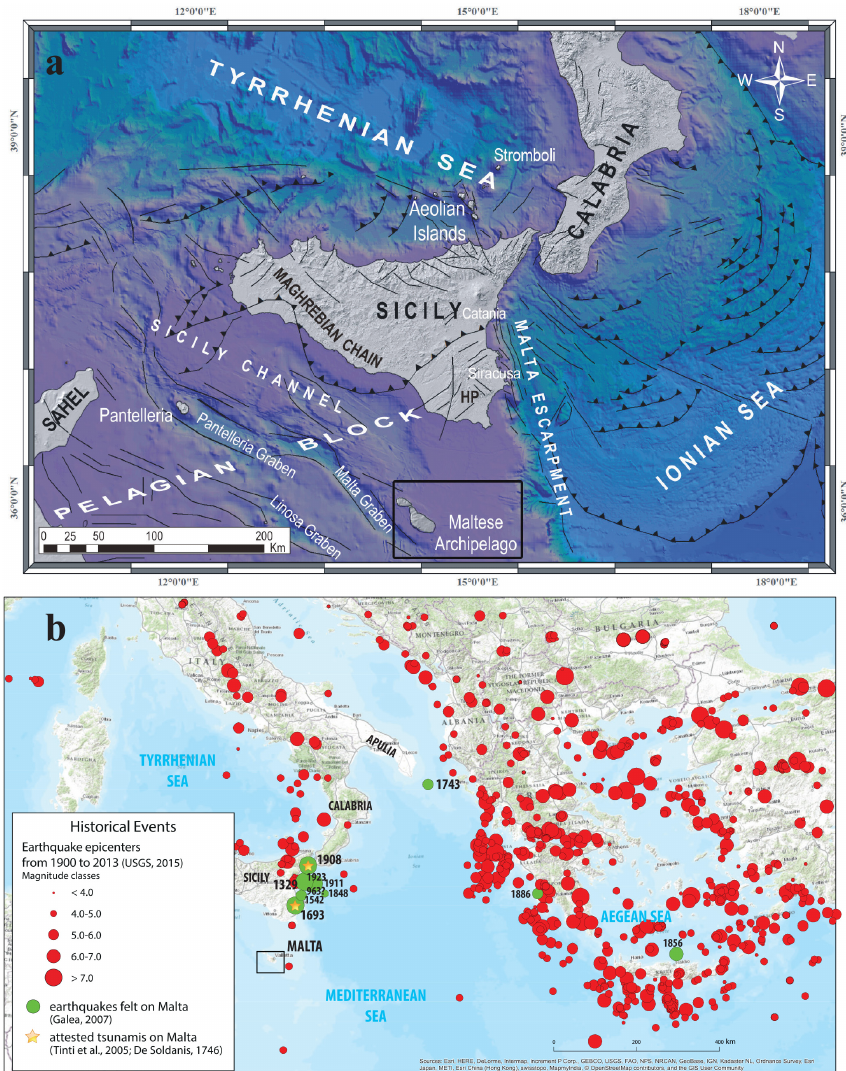
Figure 1. (a) Geodynamical setting of the Maltese archipelago (redrawn from Cultrera et al., 2015); (b) earthquakes felt on the island according to historical records (Galea, 2007) and the attested tsunamis on Malta according to De Soldanis (1746), Tinti et al. (2005) and Galea (2007), Bertolaso et al. (2008). Source: